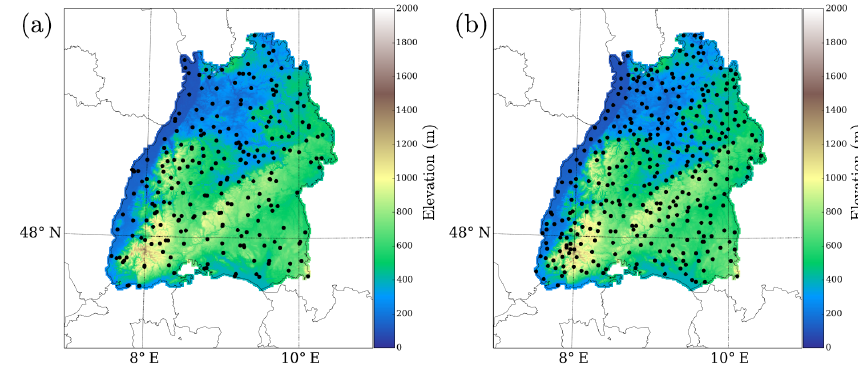
Figure 1. The locations of the high-resolution (hourly and 5min; a ) and daily rain gauges (b) in